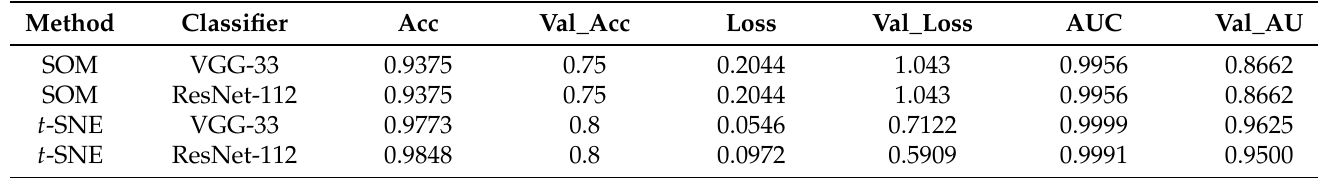
Table 5. Performance comparison among classifiers and embedding methods